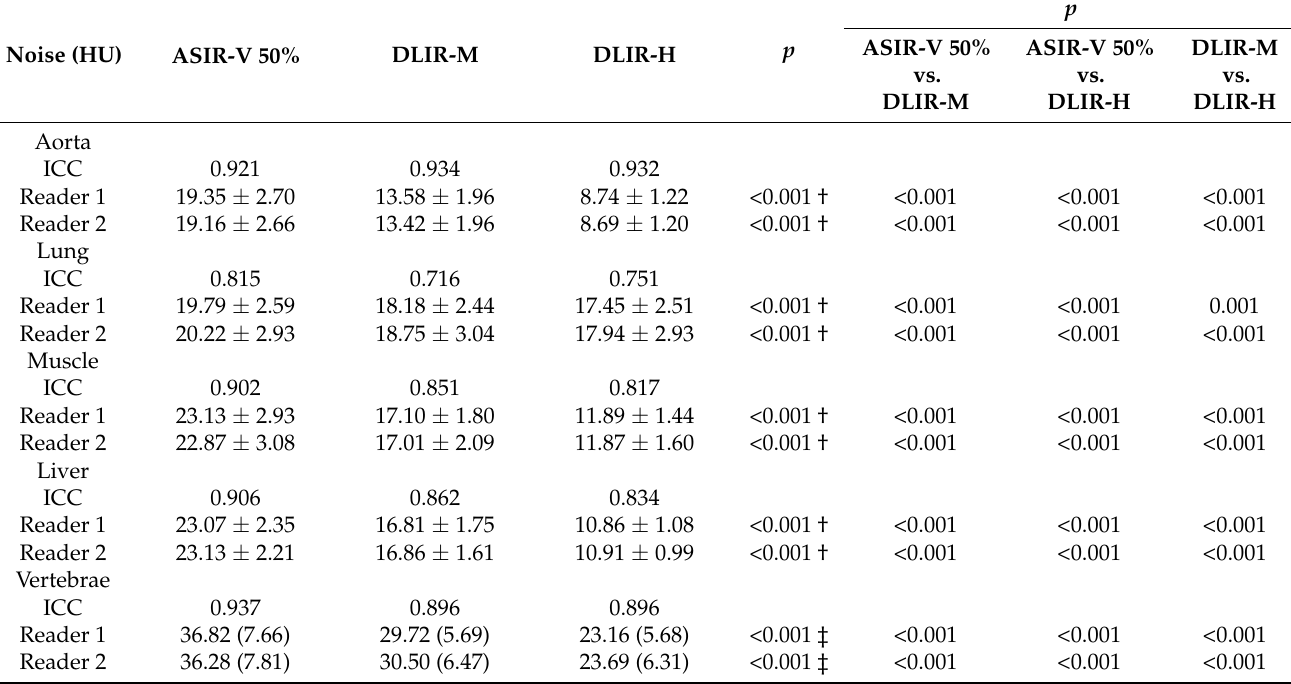
Table 2. Comparison of image noise in the three